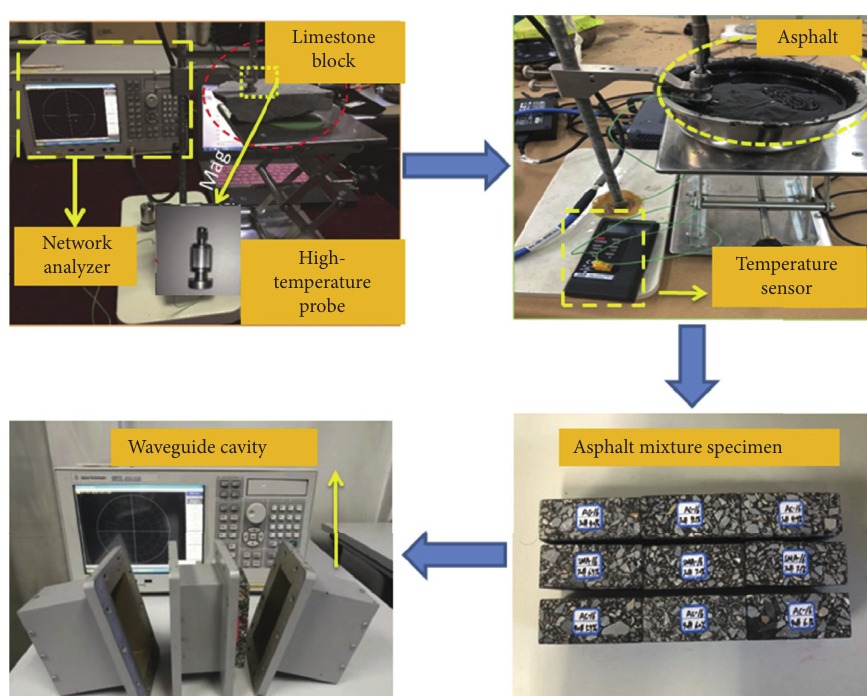
Figure 2: Measurement of permittivity of single medium and